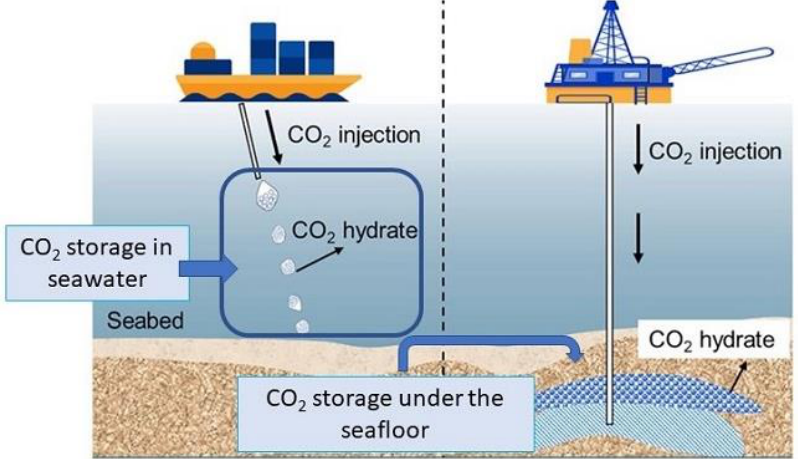
Figure 4. Approaches for CO 2 storage as CH in marine environment (adapted from [44]).